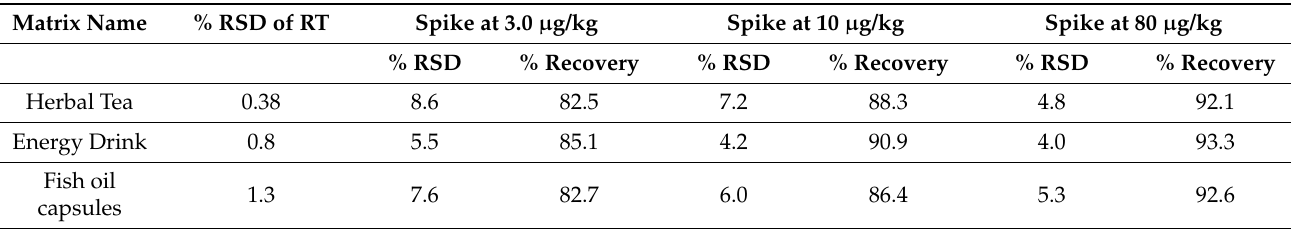
Table 9. Accuracy and Precision on day 2